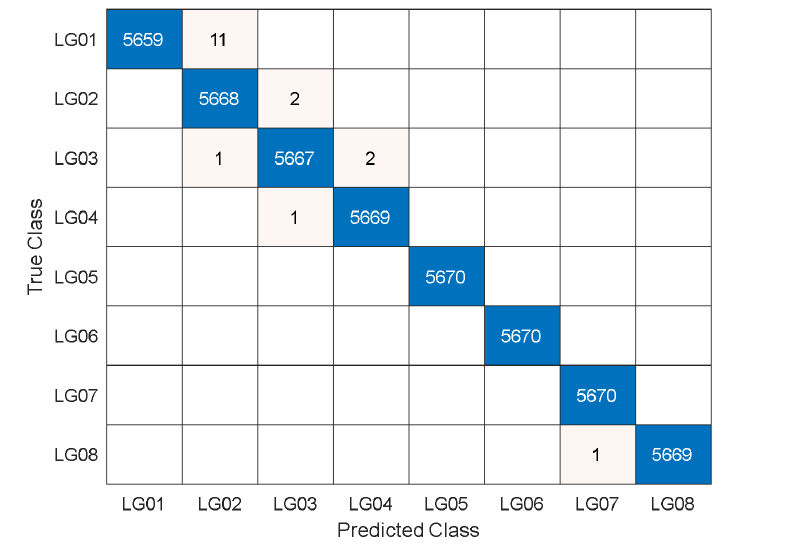
Figure 10. Confusion matrix of LG modes